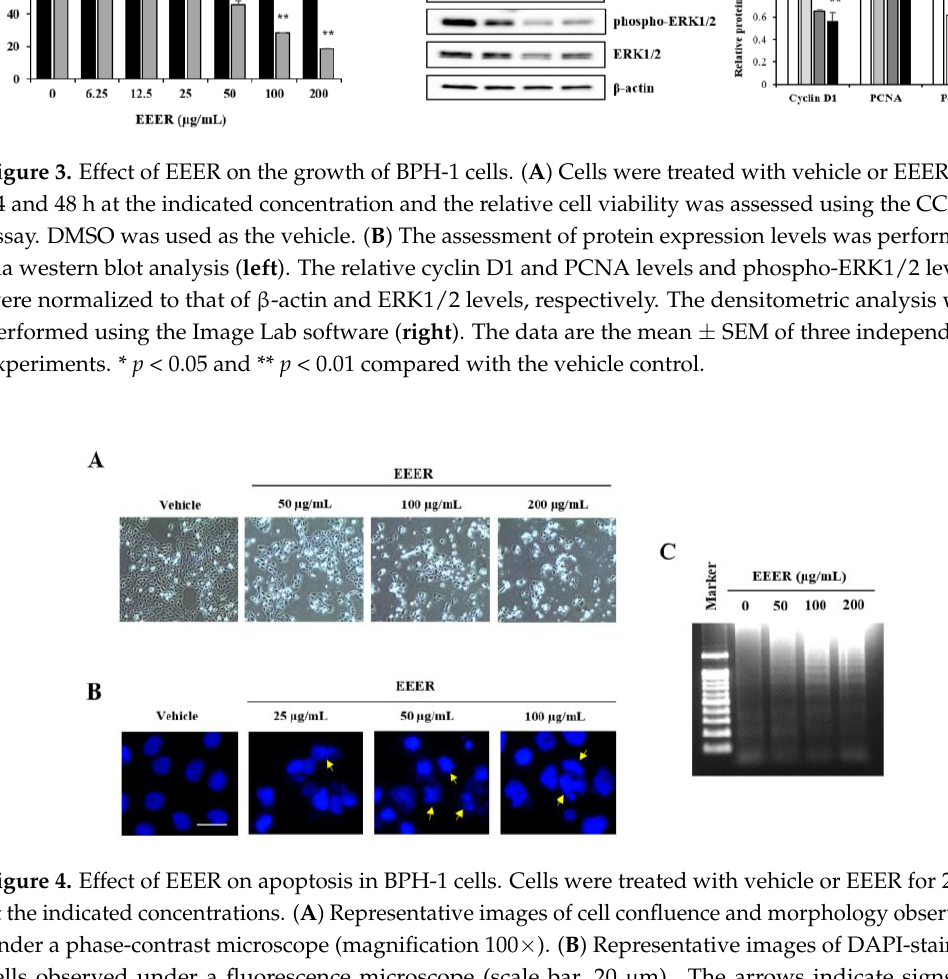
Figure 5. Effect of EEER on caspase activation in BPH-1 cells. ( A ) Caspase-3, caspase-8, and caspase-9 activities. Cytosolic extracts (200 μg) from cells treated with vehicle or EEER for 24 h were subjected to caspase-3, caspase-8, and caspase-9 colorimetric assays; ( B ) The protein levels of total PARP and cleaved PARP were assessed by western blot analysis. Data are representative of three independent experiments performed in triplicate. ** p <0.01 compared with the vehicle control. 4. Discussion The enzyme 5α-Reductase, which converts testosterone to DHT, comprises type 1, 2, and type 3 isoenzymes and plays an important role in BPH progression [12]. In this study, we first assessed whether EEER affects 5α-reductase activity. 25 μg/mL of EEER showed 80% inhibition of 5α-reductase activity which was appeared by 37 ng/mL of finasteride, an inhibitor of this enzyme (Table 1). Unlike